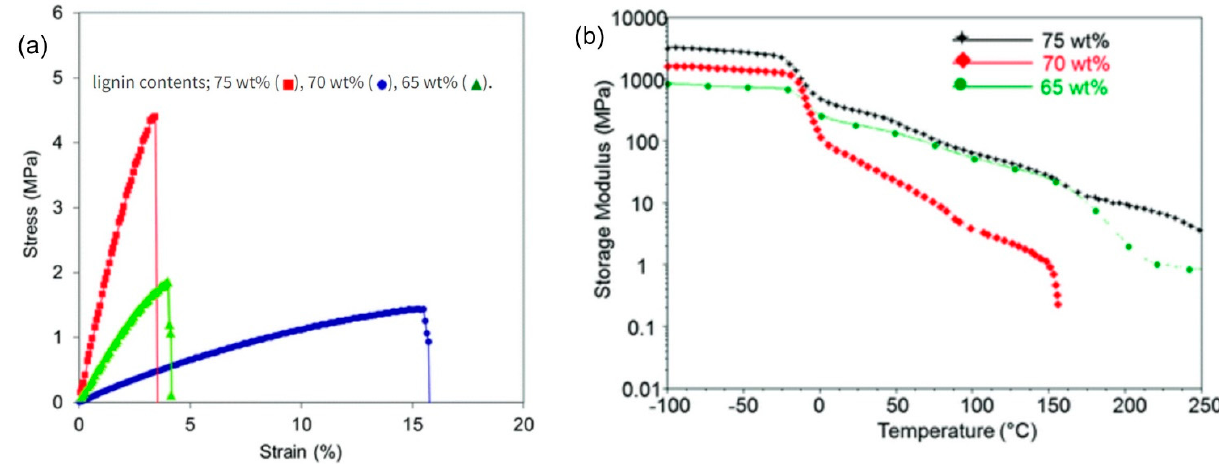
Figure 3. ( a , b ) Stress–strain behavior and storage modulus of lignin-based polyurethane thermoplastics [40].